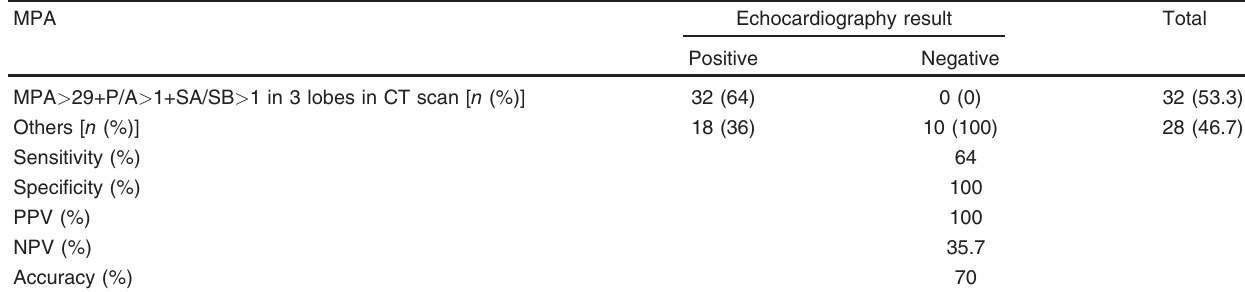
Table 14 Evaluation of different parameters: sensitivity, specificity, positive predictive value, and negative predictive value for main pulmonary artery more than 29+P/A more than 1+SA/SB more than 1 in three lobes in computed tomography scan MPA